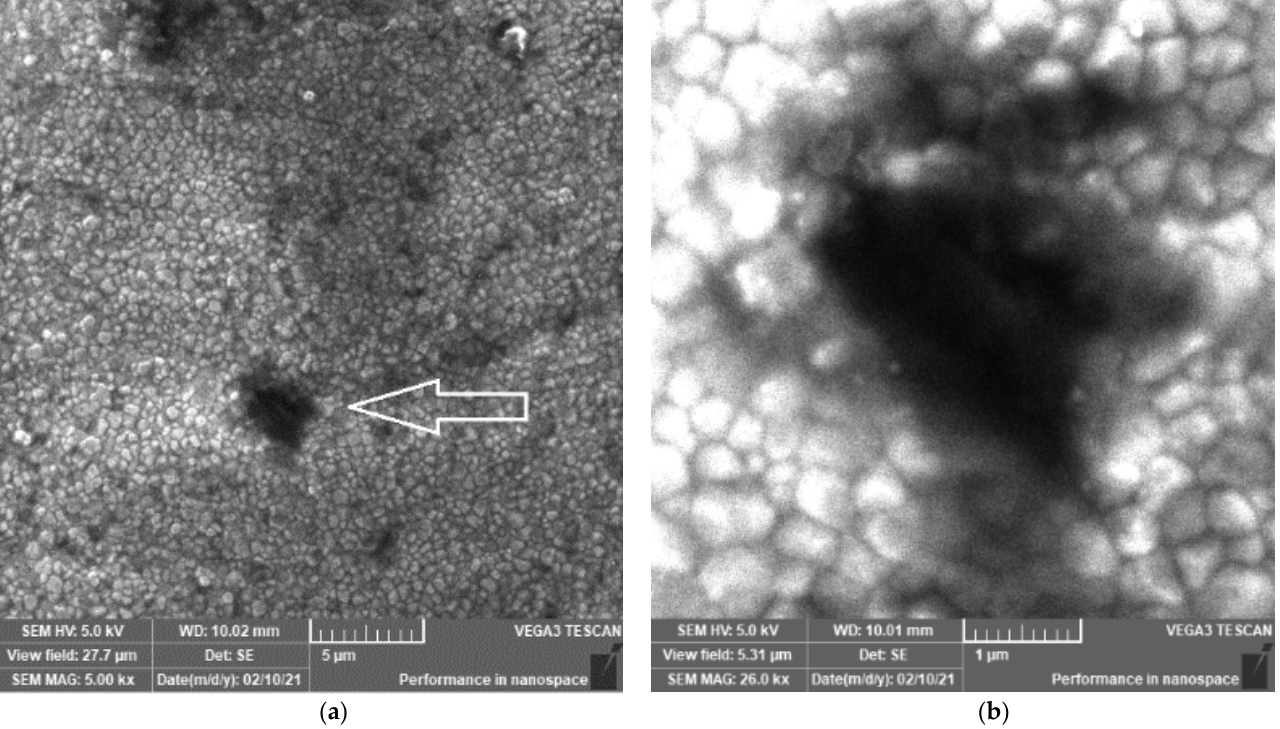
Figure 1. SEM images of different magnifications (×5000 ( a ) and ×25,000 ( b )) of the ZR control sample prepared by CAD/CAM. The morphology of ZR is characterized by grains (250–500 nm), grain boundaries and several voids (0.5–5 µm in diameter). Symbol reference: white arrow indicates hole/void.